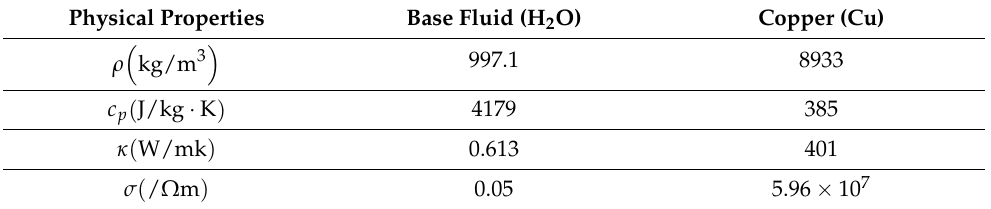
Table 2. Numerical values of thermo-physical properties of nanoparticles and base